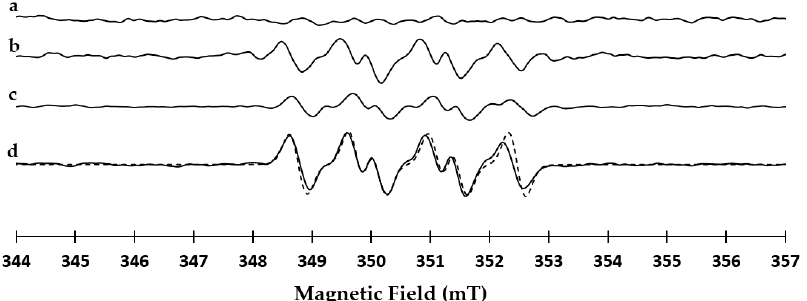
Figure 2. Line ( a ): CW (continuous wave) X-band (9 GHz) EPR spectrum at room temperature of 5,5-dimethyl-1-pyrroline N -oxide (DMPO) and dioxane; line ( b ): CW X-band (9 GHz) EPR spectrum at room temperature of DMPO, dioxane, and laccase; line ( c ): CW X-band (9 GHz) EPR spectrum at room temperature of DMPO, dioxane, laccase, and 7b ; line ( d ): CW X-band (9 GHz) EPR spectrum at room temperature of DMPO, dioxane, laccase and 11h (bold line) paired to it simulation (dotted line). The spectra reported in line a and b were acquired at t = 0 min and those in line c and d at t = 180 min.